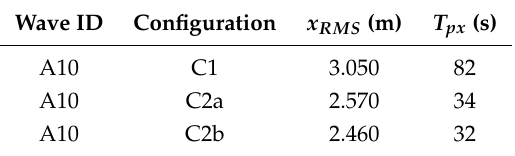
Table 12. Surge motion spectral properties: 10-year wave.